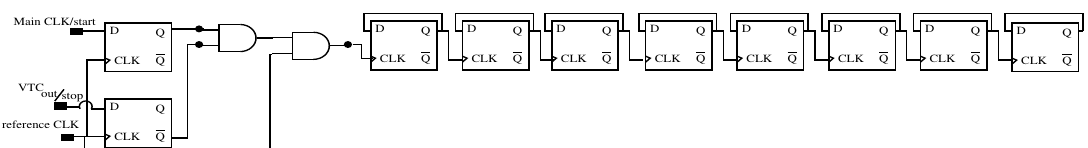
Figure 13. Schematic diagram of the asynchronous counter-based time-to-digital converter